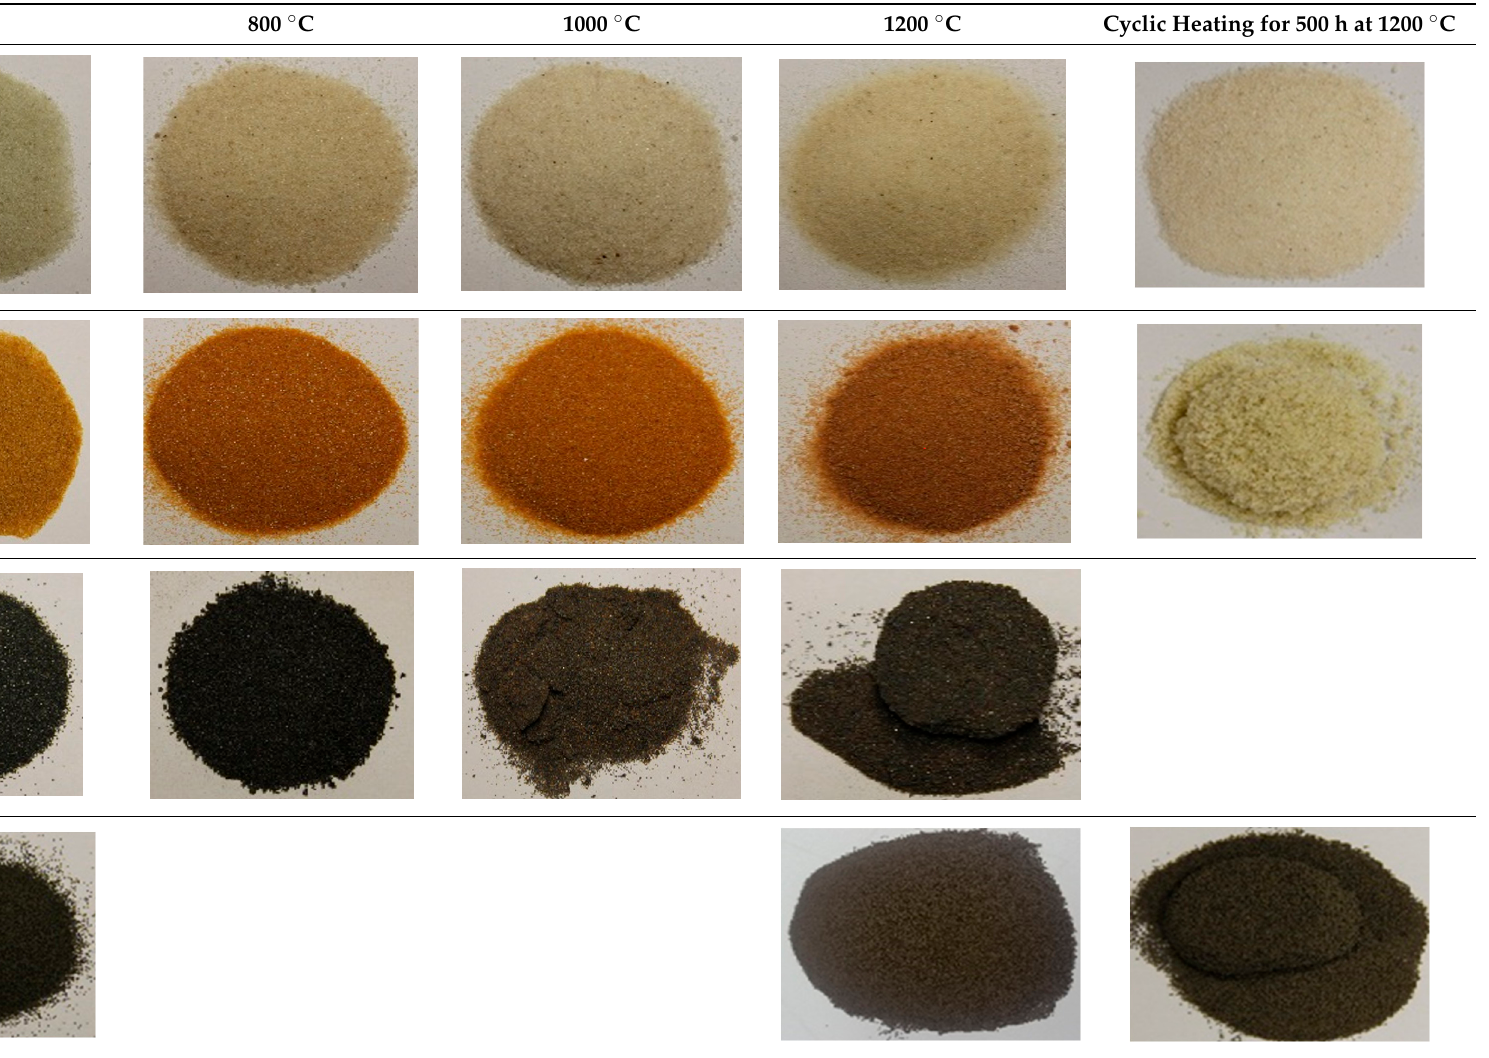
Table 2. Photographic images of the candidate particulate materials after heating at different temperatures.